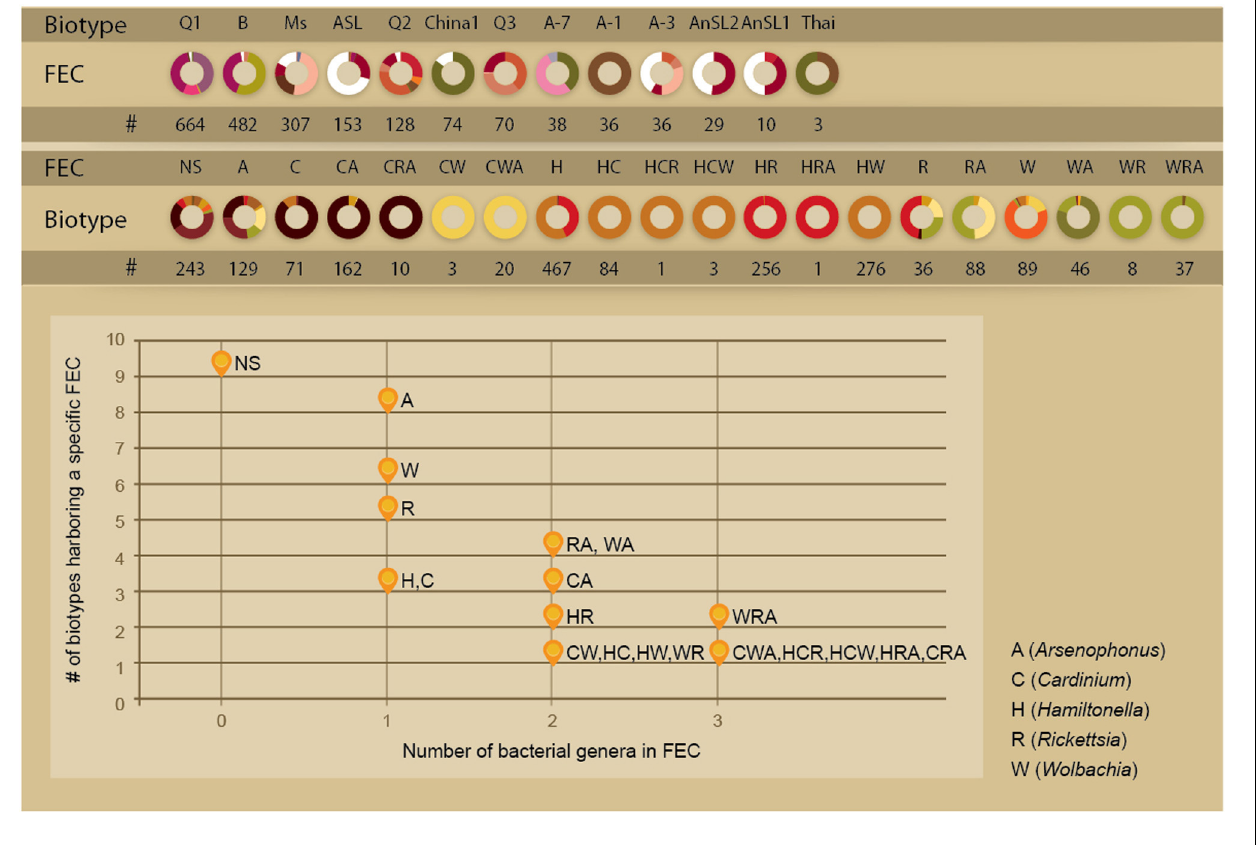
correlation remains significant after controlling for the number of whitefly individuals carrying a FEC entity. (Pearson: 0.7708, P- value 6e–5). A-7/1/3 biotypes stand for Asia II 7/1/3, respectively. NS, no symbionts; FEC, facultative endosymbiont combination; #, sample